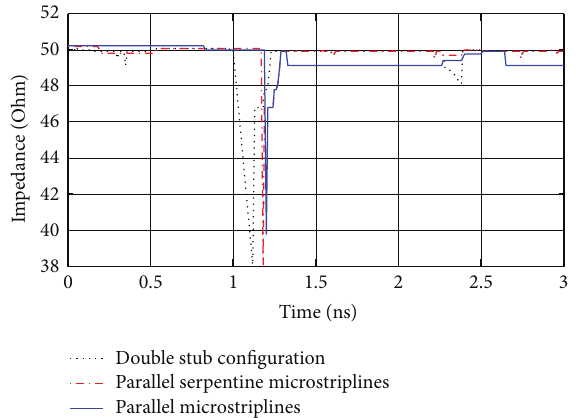
Figure 9: Characteristic impedance